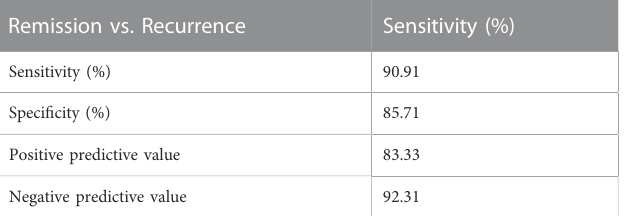
TABLE4Sensitivity,speci fi city,positivepredictivevalue,andnegativepredictive value obtained with the algorithm. Remission vs.